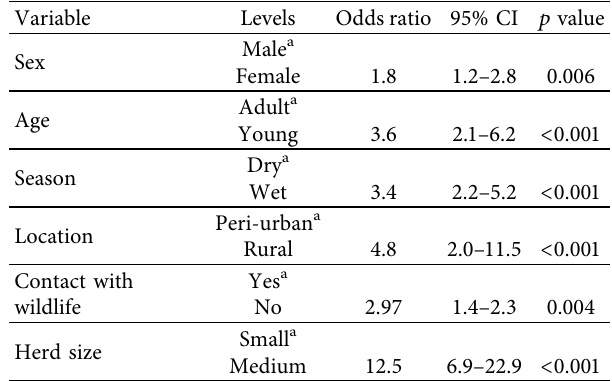
Table 3: Multivariate logistic regression analysis showing risk factors associated with the brucellosis seroprevalence in cattle from 20 commercial dairy farms in the eastern coast zone of Tanzania.